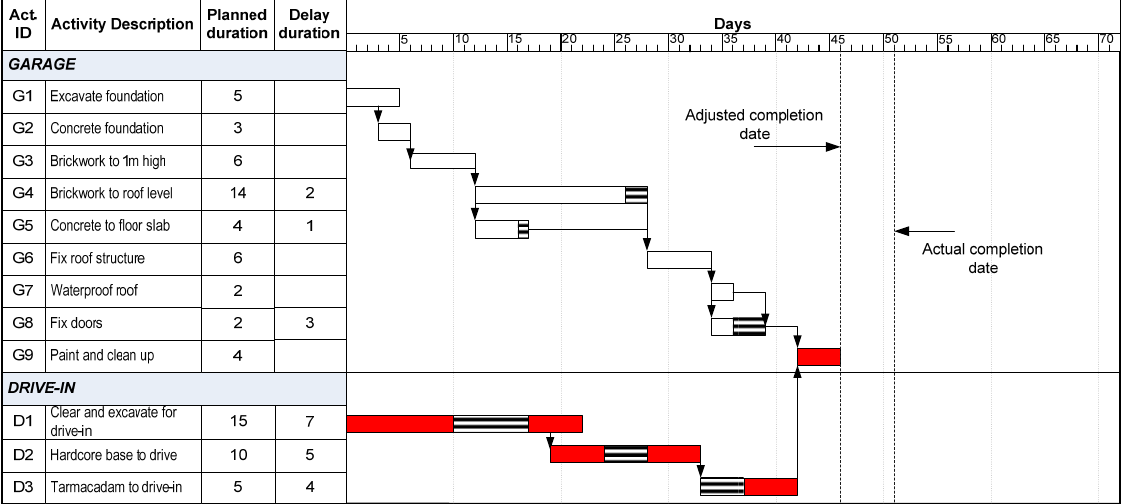
Figure 17. As-built schedule with contractor’s delays